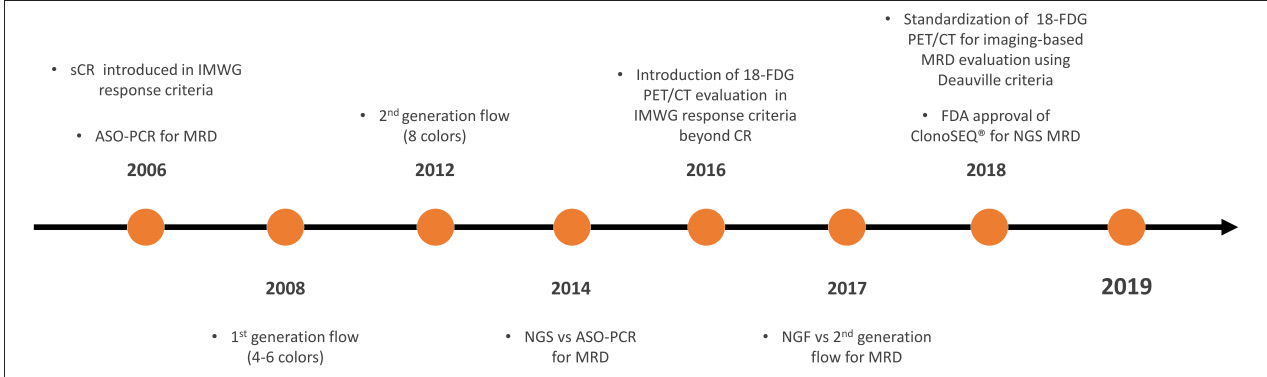
FIGURE 1 | Timeline on the development and validation of MRD techniques in MM. MRD, minimal residual disease; MM, multiple myeloma; CR, complete response; sCR, stringent CR; IMWG, International Myeloma Working Group; ASO-PCR, allele-specific oligonucleotide polymerase chain reaction; NGS, next-generation sequencing; 18-FDG PET/CT, 18-fluorodeoxyglucose positron emission tomography/computed tomography; ClonoSEQ ® , ClonoSEQ ® Assay (Adaptive Biotechnologies, Seattle, US-WA); FDA, Food and Drug Administration.